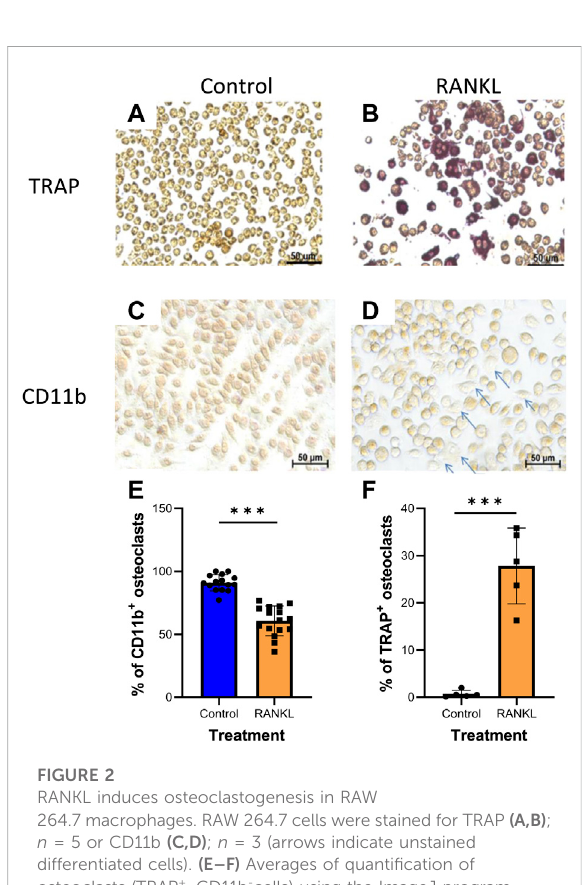
FIGURE 2 RANKL induces osteoclastogenesis in RAW 264.7 macrophages. RAW 264.7 cells were stained for TRAP (A,B) ; n = 5 or CD11b (C,D) ; n = 3 (arrows indicate unstained differentiated cells). (E – F) Averages of quanti fi cation of osteoclasts (TRAP + , CD11b - cells) using the ImageJ program. Statistical signi fi cance by Student ’ s t -test between control and RANKL treatments is indicated. *** p <